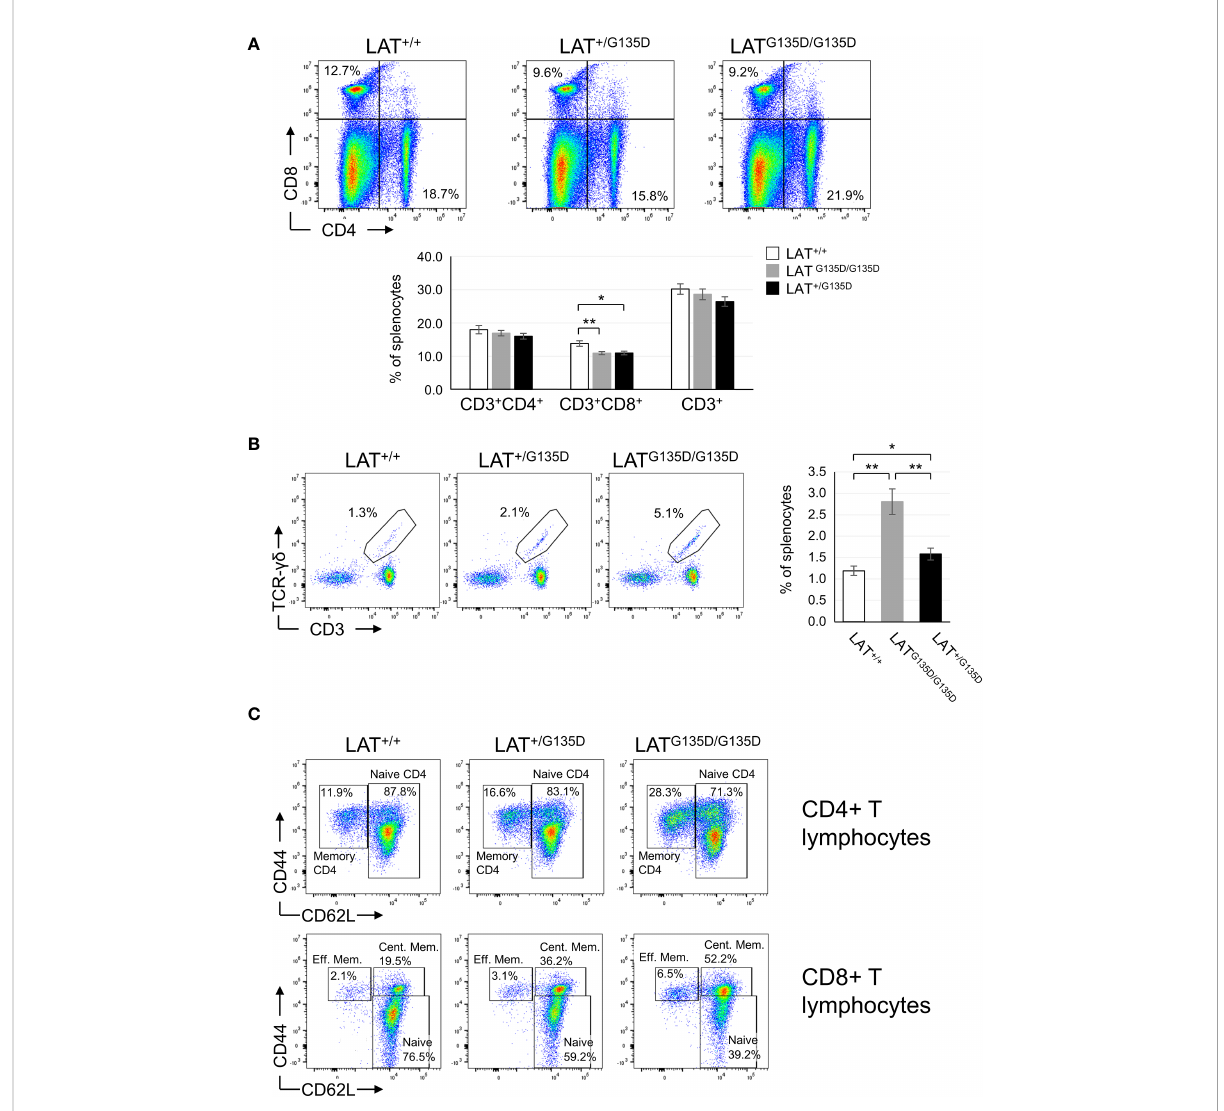
FIGURE 2 Peripheral lymphocyte populations are altered by the LAT-G135D mutation. (A) CD4 and CD8 expression was analyzed in splenocytes from wild- type (LAT +/+ ), heterozygous (LAT +/G135D ), and homozygous (LAT G135D/G135D ) mutant mice (upper panels) by fl ow cytometry. The numbers indicated in each quadrant represent the percentage of cells. Upper panels show a representative experiment. Lower bar graph represents the average of the indicated populations after the analysis of LAT +/+ (n = 14), LAT +/G135D (n = 9), and LAT G135D/G135D (n = 13) mice. The brackets on each bar represent the mean standard error. (B) Dot plots showing CD3 and TCR- gd expression in splenocytes cells from the indicated types of mice. The bar graph on the right shows the percentages of gd -T cells in each mouse type: n = 13 for LAT +/+ , n = 9 for LAT +/G135D , and n = 11 for LAT G135D/G135D . (C) Analysis of memory and naive CD4 (upper dot plots) and CD8 (lower dot plots) T cells in spleen from wild-type (LAT +/+ ), heterozygous (LAT +/G135D ), and homozygous (LAT G135D/G135D ) mutant mice. The numbers in the depicted regions represent the percentage of